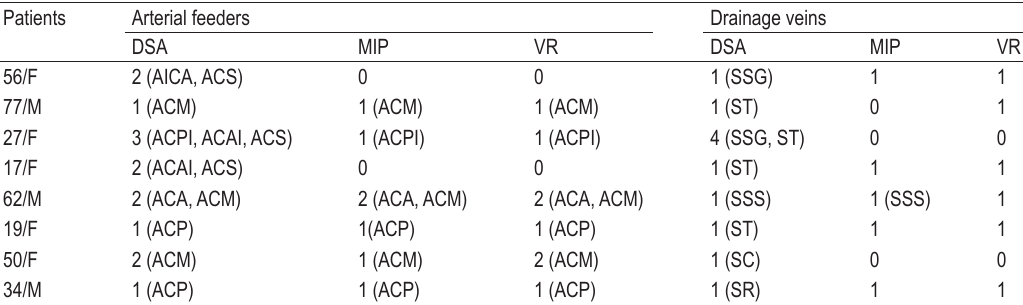
TABLE 1. Characteristics of AMV diagnosed in patients. Correlation between CTA MIP and VR reconstructions and DSA= Patients Arterial